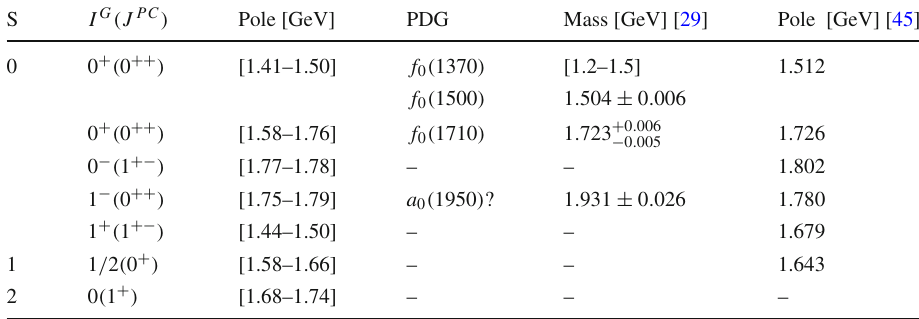
poles obtained in this work with those in Ref. [45]. Only the real parts of the pole positions (in GeV) are given. The ranges of our results cover those obtained using the parameters in Table